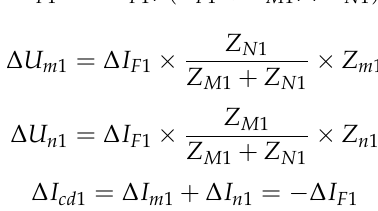
Figure 5. Positive sequence fault component network diagram for out-of-zone faults.